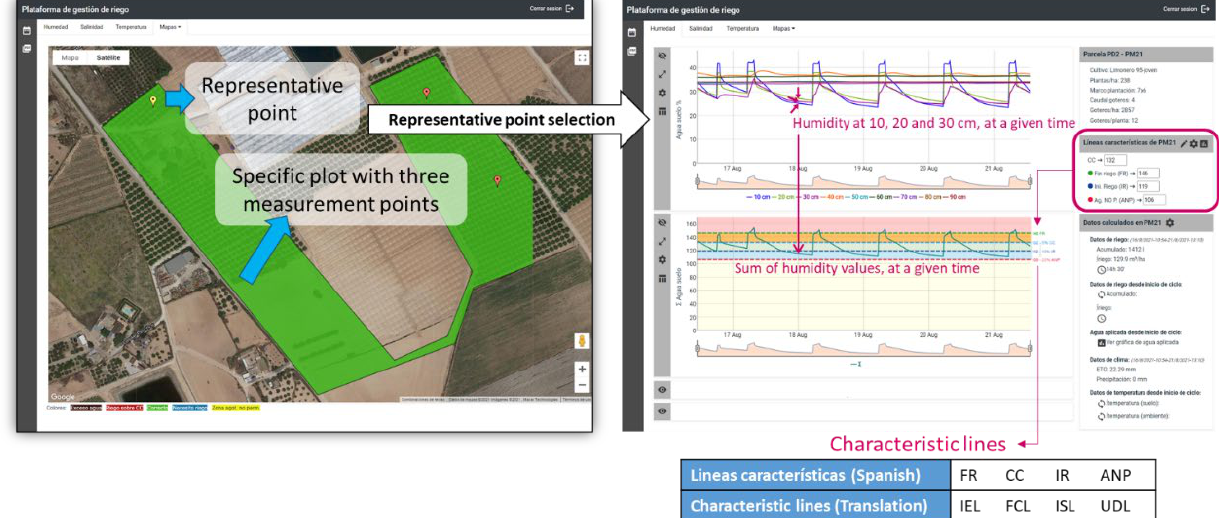
Figure 6. Representation of a specific plot. Three measurement points are defined. The plot’s representative point is marked with yellow color. For example, if the representative point is selected, data from the last week are downloaded and suitably represented by using charts. The second chart shows a time series defined as the sum of humidity values at depths of 10, 20 and 30 cm, since in this sample, the user had specifically selected such depths for the aggregation operation. Characteristic lines have been manually defined according to an agronomic expert’s knowledge.